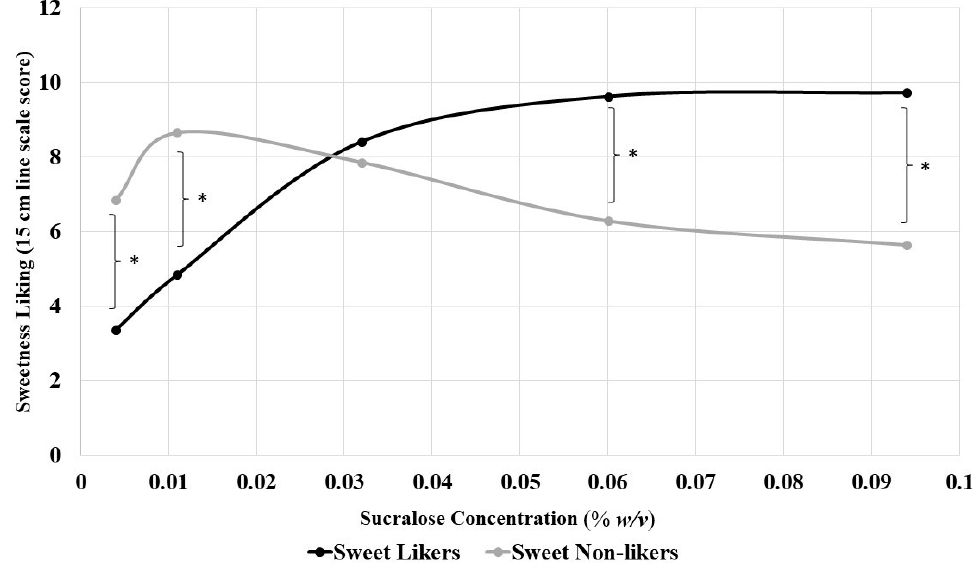
Figure 1. Comparison of sweet liking response, averaged across both sleep conditions, by sweet liking phenotype (sweet likers and non-likers) determined using hierarchical cluster analysis based on liking scores over the range of sucralose solutions after a habitual night of sleep. Likers and non-likers showed distinct patterns of liking with sweet likers showing higher sweetness liking at 0.06% and 0.094% w / v sucralose and lower sweetness liking at 0.004% and 0.011% w / v sucralose, regardless of sleep condition (* p < 0.001 for all).